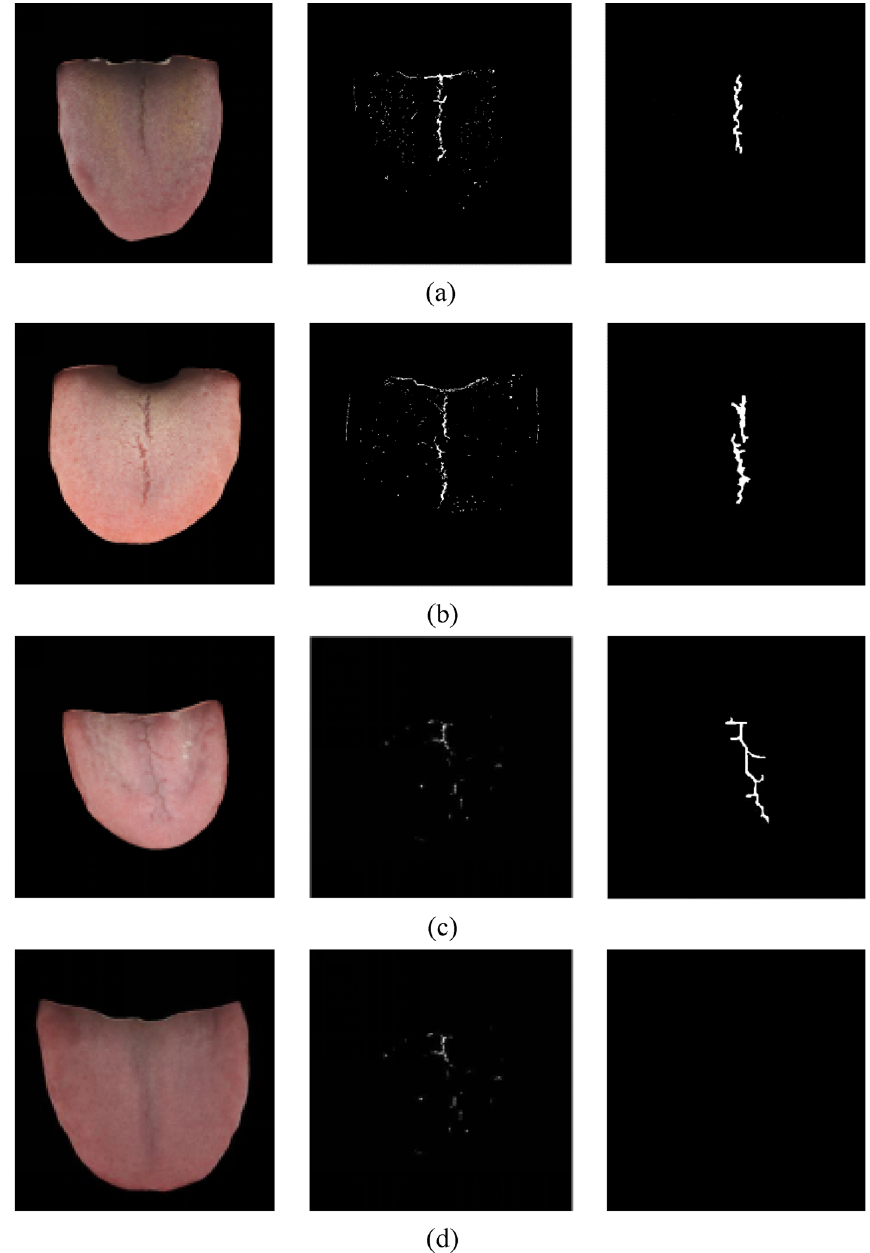
Figure 6. Comparison of crack extraction. ( a ) single-crack tongue ( b ) double-crack tongue ( c ) multi-crack tongue ( d ) non-crack